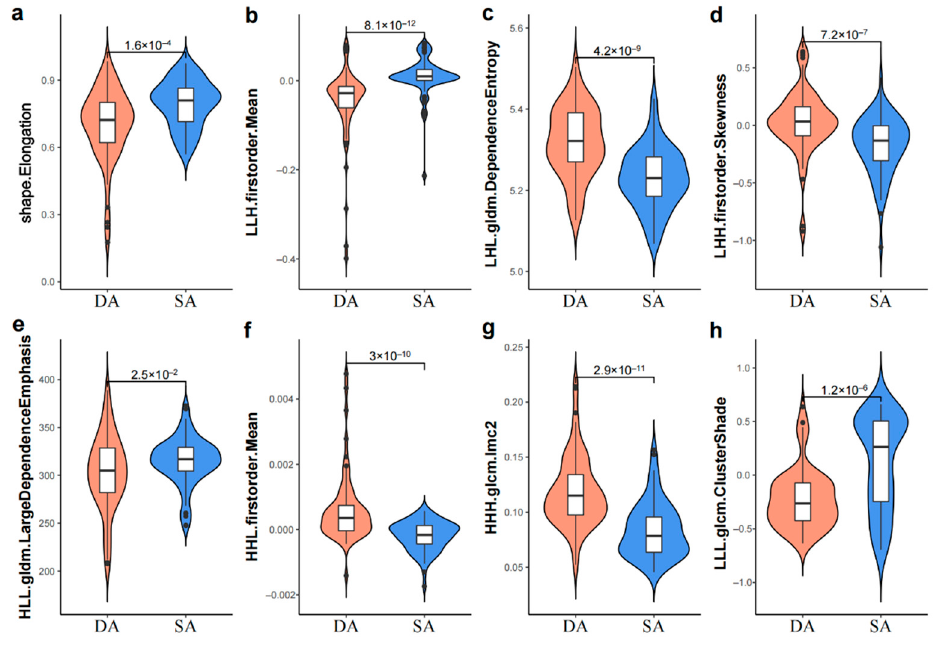
Figure 3. The violin plots of eight features ( a – h ) in the radiomic model. Figure 4 shows an example of representative MRI images. In the training set, the integrated model improves the diagnostic performance in terms of AUC, ACC, and SPE (Table 2), which is superior to both the radiomic model and the clinico-radiological model (Figure 2a). When applying these models to the external validation set, the radiomic model performs the best, even better than the experienced radiologists (Figure